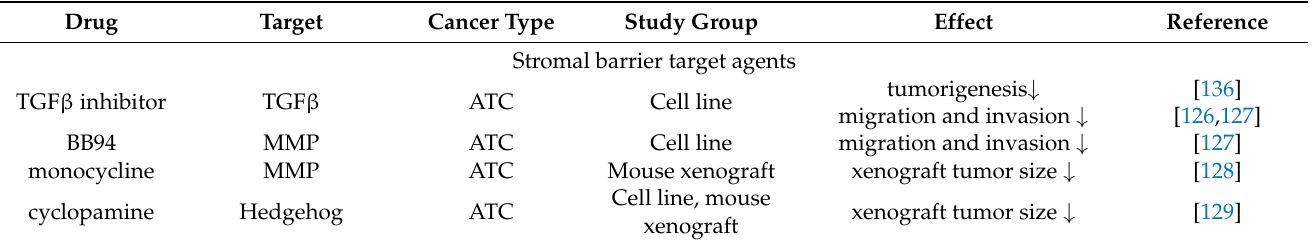
Table 1. CAF inhibitors in thyroid